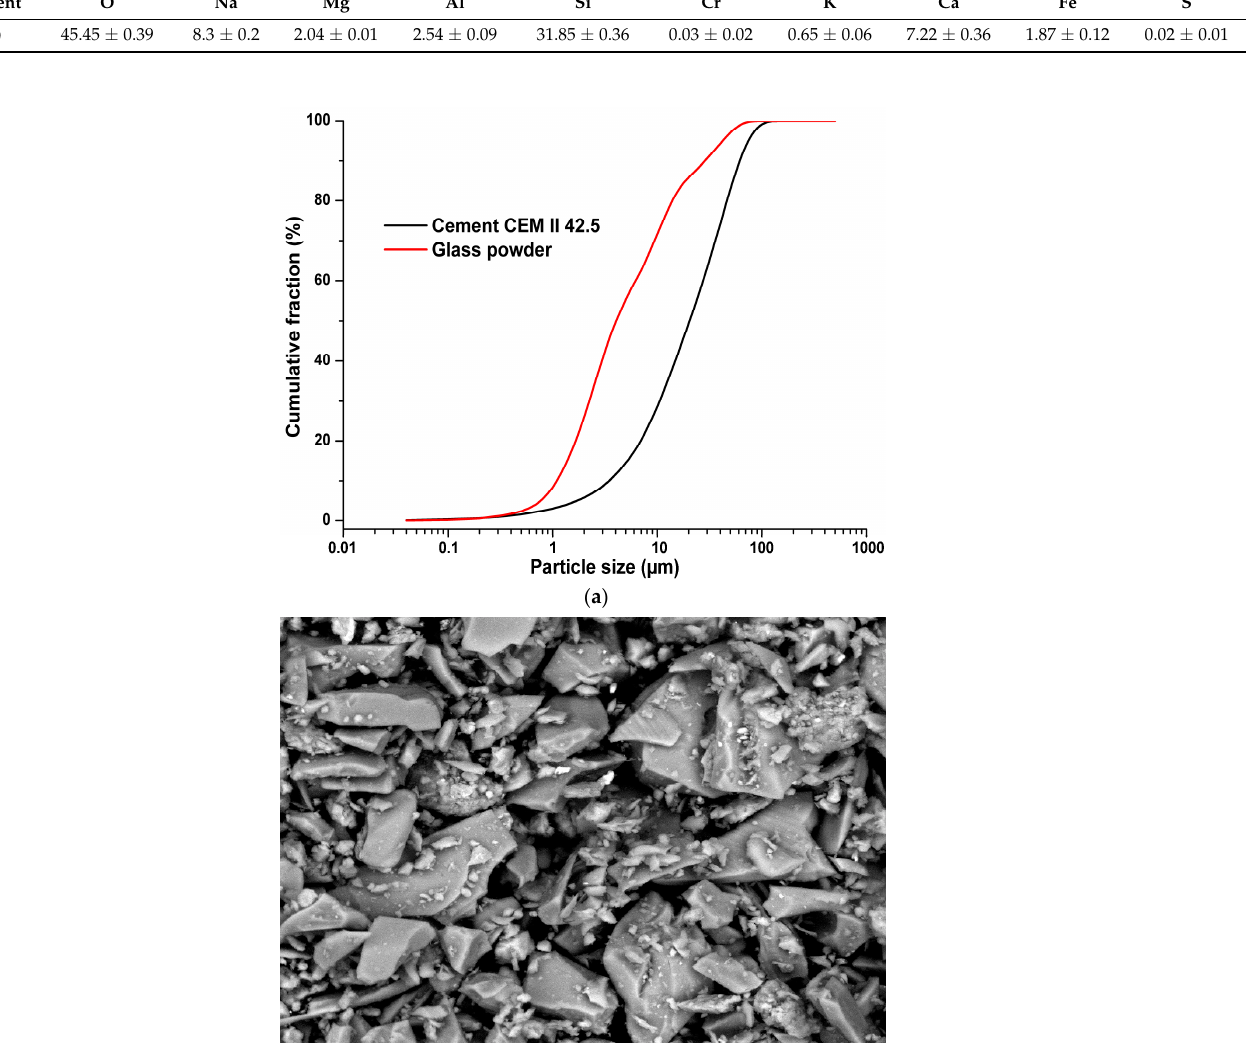
Table 4. Mix designs of one cubic meter of concrete in kg/m 3 . Designation